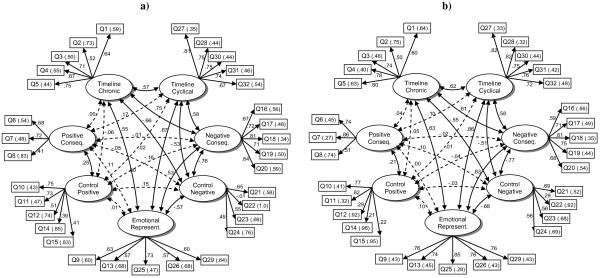
APQ questionnaire confirmatory factor analysis in subjects 65 or older (Figure1a) and in subjects aged 55 to 65 (Figure1b). On this figure, ovals represent factors and rectangles questionnaire items. Inside rectangles are given the item number (see Additional file 1 for litteral items) and its standardized error variance estimate in parentheses. Unidirectional arrows represent associations between factors and items according to the CFA model with standardized factor loadings estimates. Bidirectional arrows represent factor correlations with their estimates; dotted lines are associated with low correlations (< .20). Conseq. Positive and Conseq. Negative: sub-dimensions consequences positive and consequence negative Emotional represent.: dimension emotional representations.